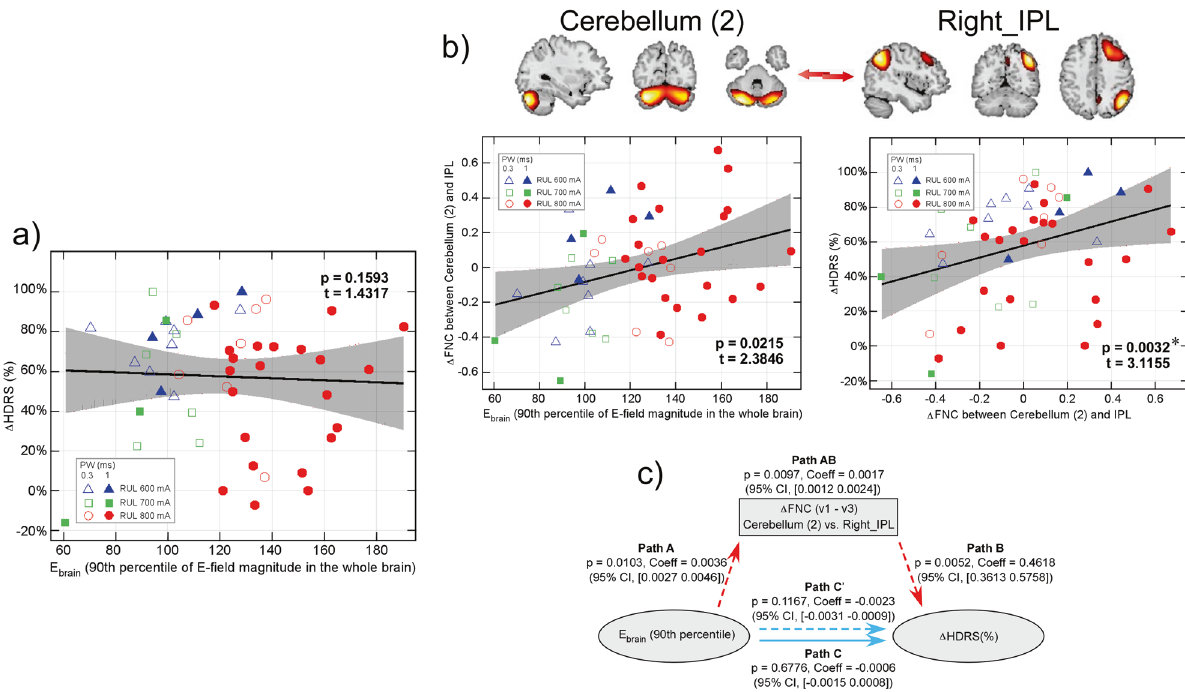
Fig. 4 E brain , cerebellum-right IPL FNC neuroplasticity and antidepressant outcomes. a E brain is not correlated with Δ HDRS. b changes in FNC between cerebellum (2) and right IPL is positively correlated with E brain and Δ HDRS. c Δ cerebellum-IPL FNC mediates the effects of E brain on Δ HDRS. * Signi fi cance p < 0.05, FDR corrected. E brain the 90 th percentile of electric fi eld magnitude in the brain, IPL inferior parietal lobule, FNC functional network connectivity, HDRS Hamilton Depression Rating Scale-24 item, FDR false discovery